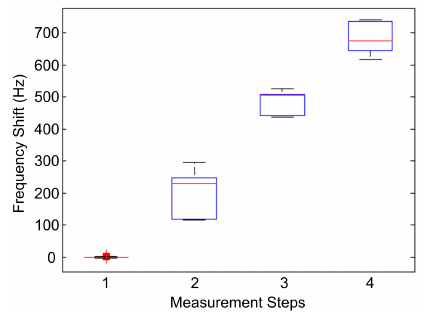
Figure 7. Box plot related to the four steps of data set collection. The measurement steps correspond to (1) determination of zero, (2) avidin, (3) antibody, and (4) stem cells. Each box shows the median (red), 25th and 75th percentile (blue borders), and maximum and minimum (bases in black).